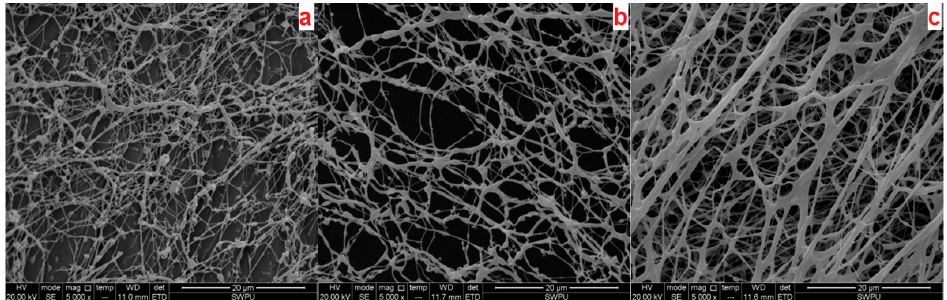
Figure 11. SEM of 0.15 wt.% drag reducers in fresh water: ( a ) PHWAM-1, ( b ) PHWAM-2, and ( c ) PHWAM-3.